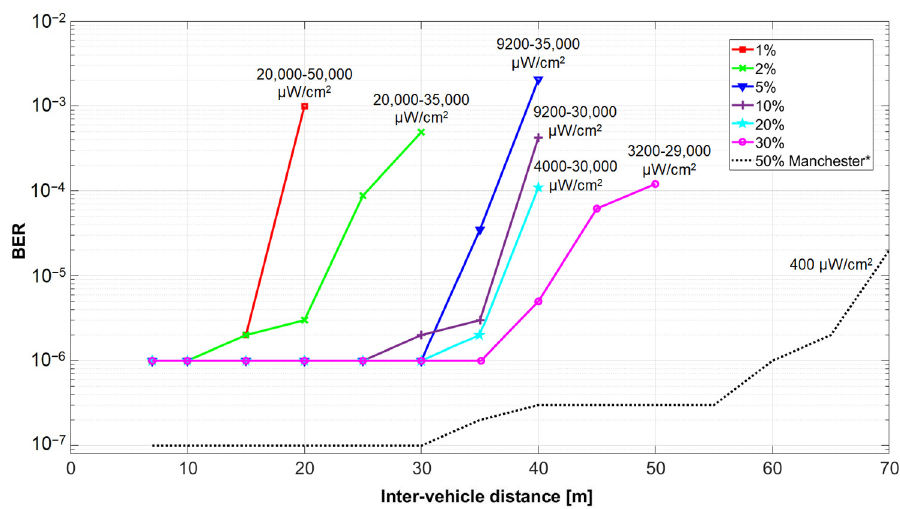
Figure 14. Outdoor experimental setup.